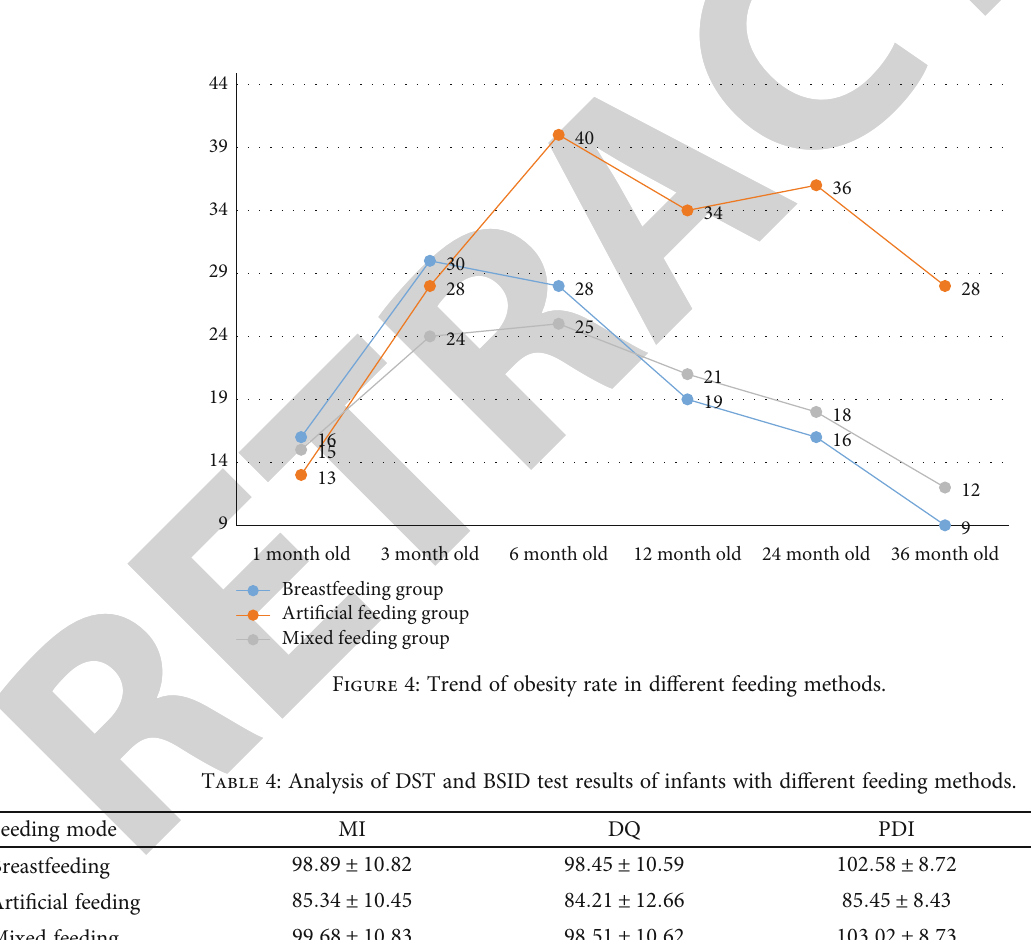
Figure 3: Trend of lean rate in di ff erent feeding methods.